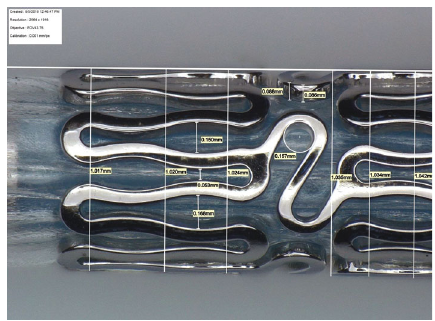
Figure 1: Osum stent (crimped).